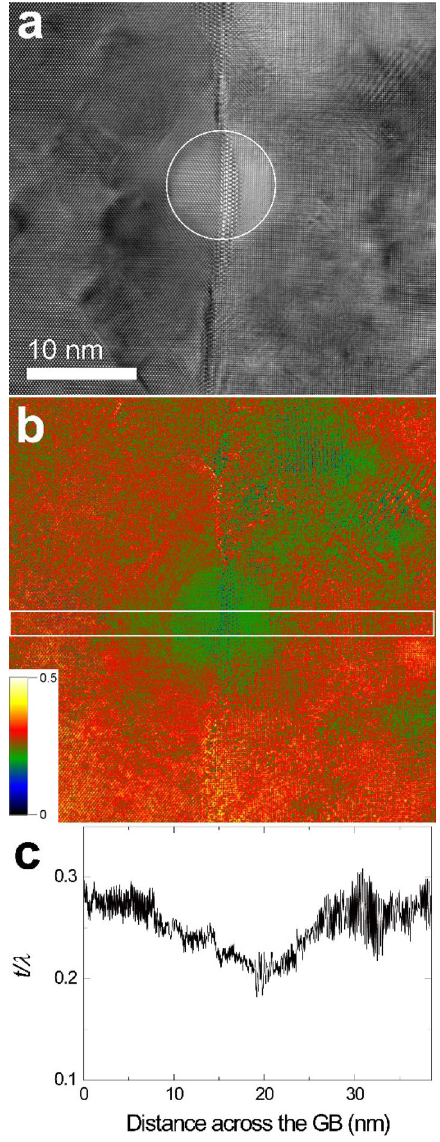
Figure 7. ( a ) EFTEM image (unfiltered) obtained from a beam irradiated area at 10 nm for 1 min 50 s and ( b ) a corresponding thickness map. ( c ) Line profile of relative thickness for the rectangular area shown in ( b